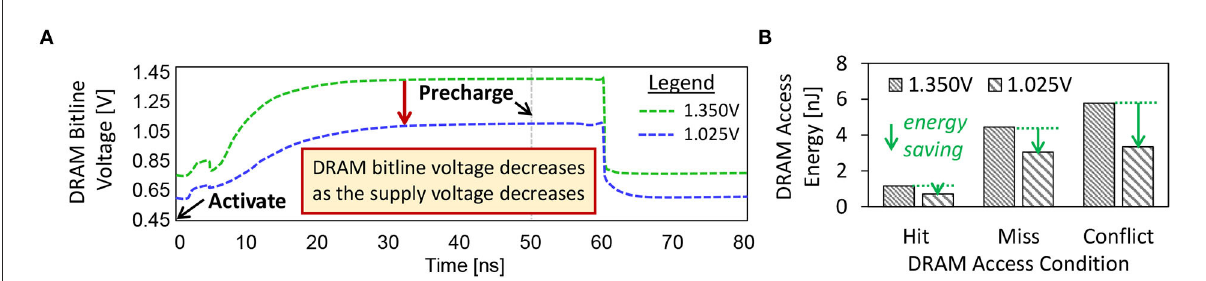
FIGURE2 (A) The dynamics of V bitline under different V supply values. (B) DRAM access energy for a row buffer hit, a row buffer miss, and a row buffer conflict, under different V supply